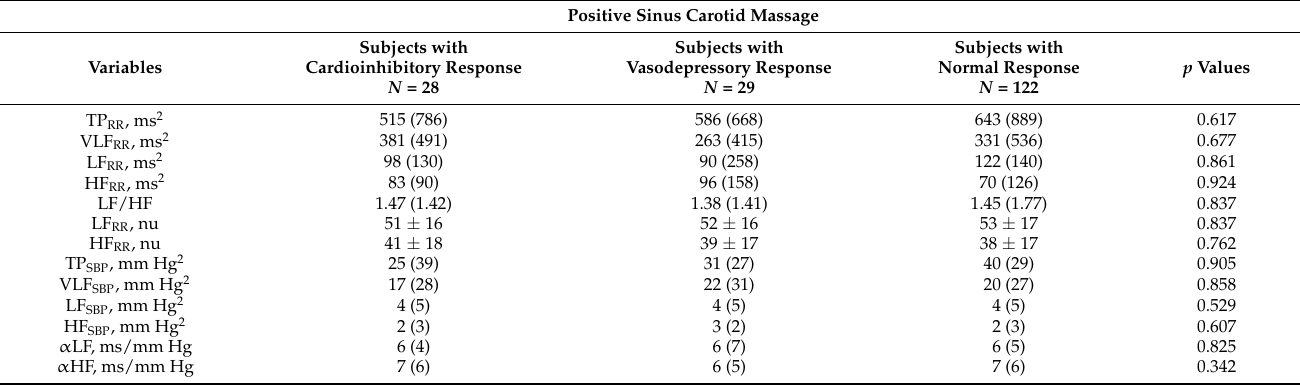
Table 5. 5 Minutes of ECG and Pressure Data during Controlled